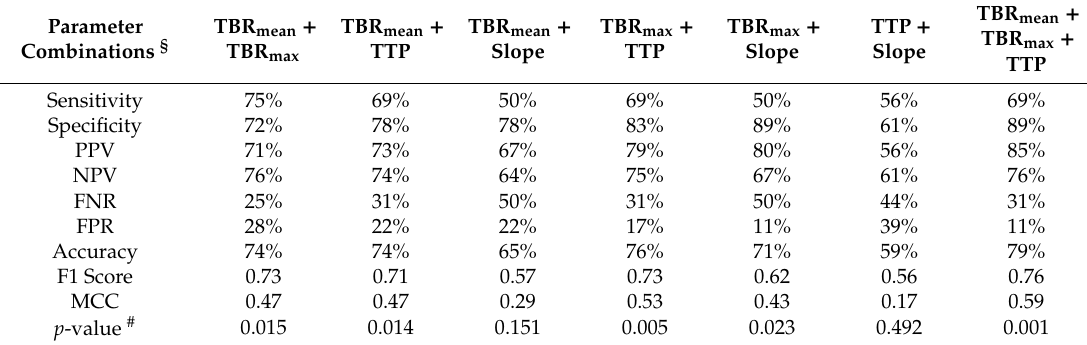
Table 3. Classification results of conventional FET PET parameter combinations for di ff erentiating pseudoprogression from early tumor progression.